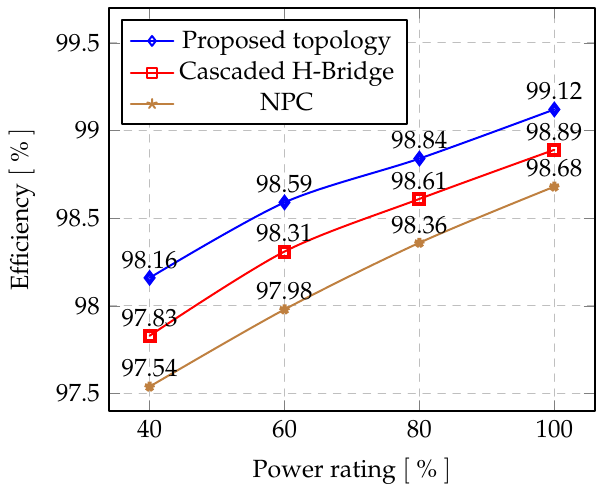
Figure 7. Comparison of proposed topology with traditional five-levels topologies.